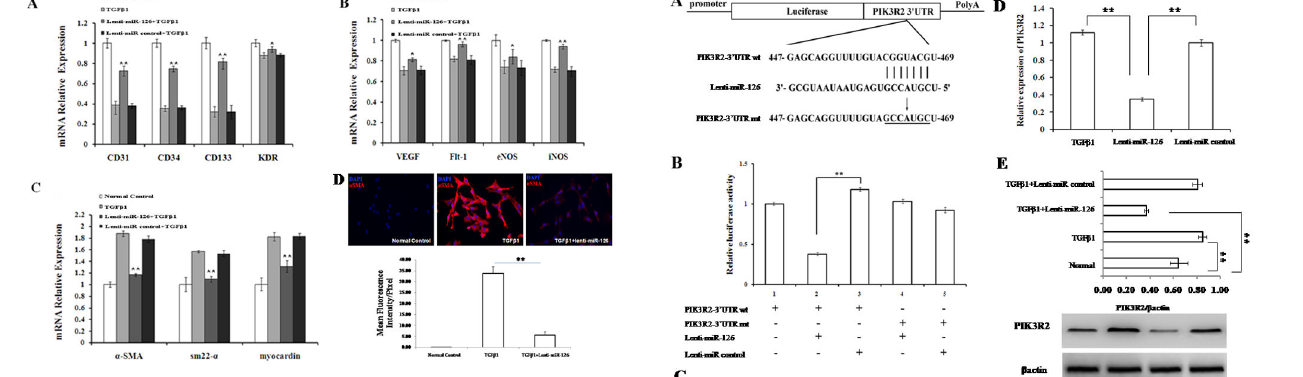
Figure 2. Overexpression of miR-126 inhibited the EndMT process of EPCs induced by TGFβ1. (A) The mRNA transfected with a miR-126-expressing lentiviral vector, an empty vector (lentivector), or neither, and EPCs without any treatment were used as the normal control. EPCs infected with an empty vector were used as the Lenti-miR control. Data shown are representative of 3 independent experiments. **, P < 0.01 compared with the Lenti-miR control.